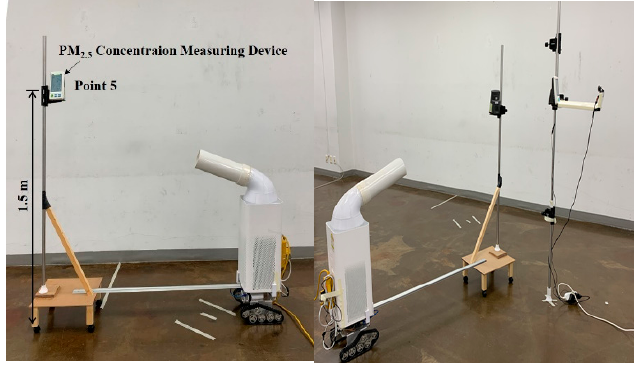
Figure 10. A method of implementing the air purifier that tracks occupants in real-time.